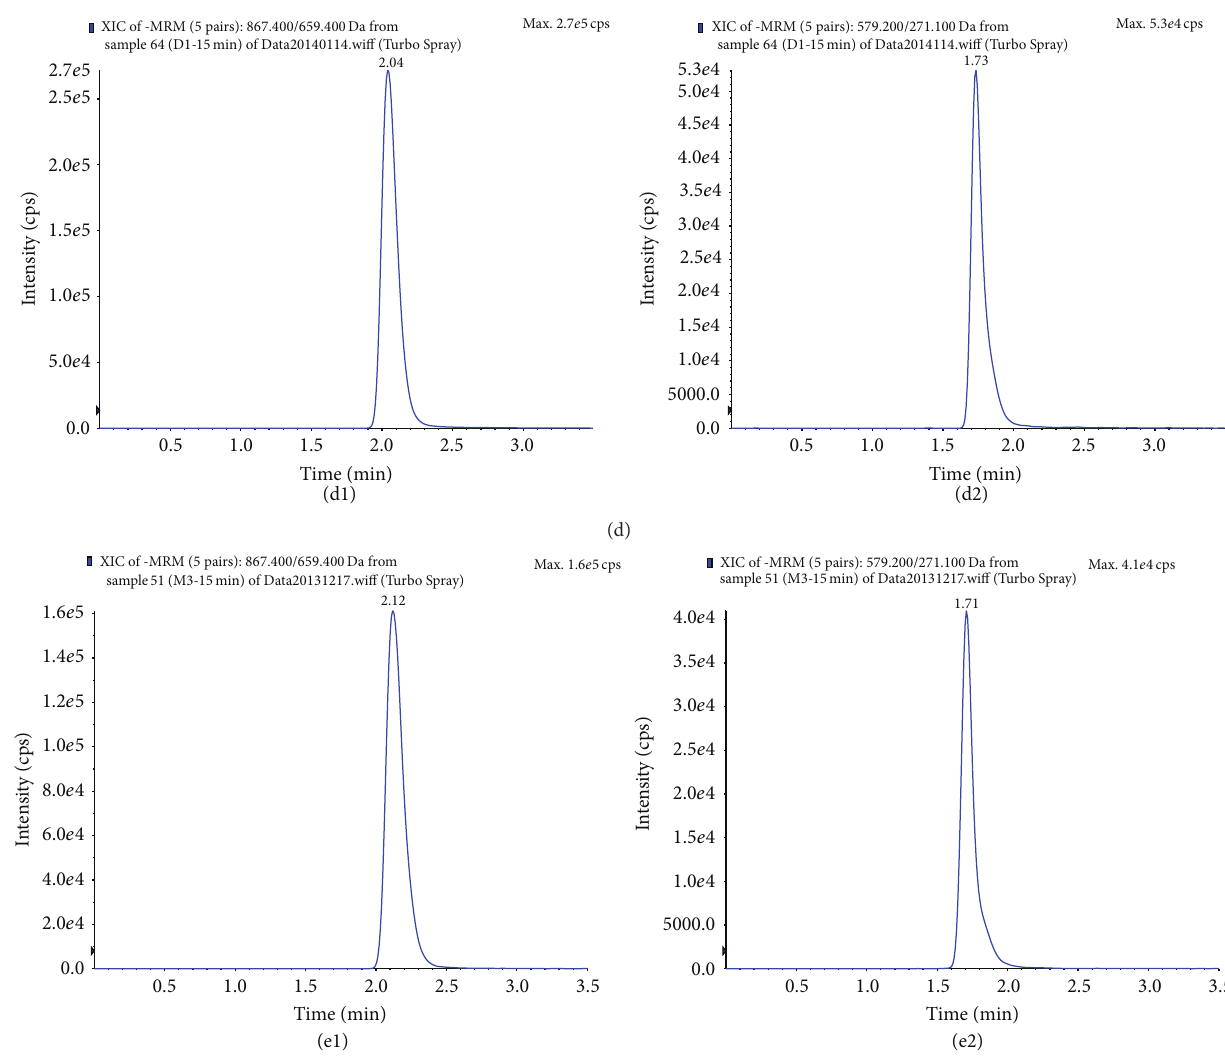
XIC of -MRM ( 5 pairs): 867.400 / 659.400 Da from sample 51 (M 3 - 15 min) of Data 20131217 .wiff (Turbo Spray)